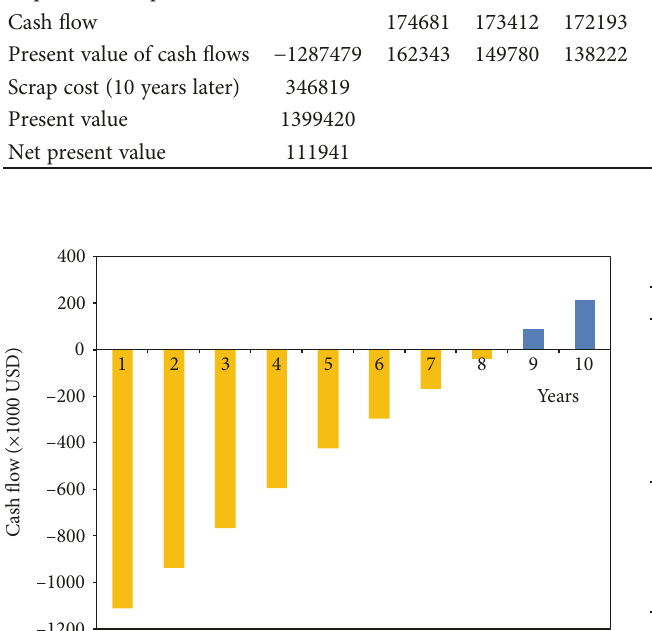
Table 9: Economic indicators for IRR.